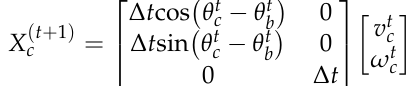
Acceleration Angular Acceleration Range